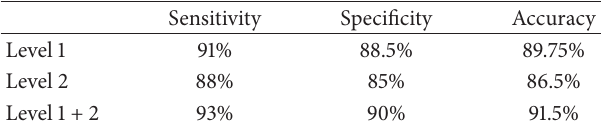
Table 3: Results obtained using the proposed feature in B